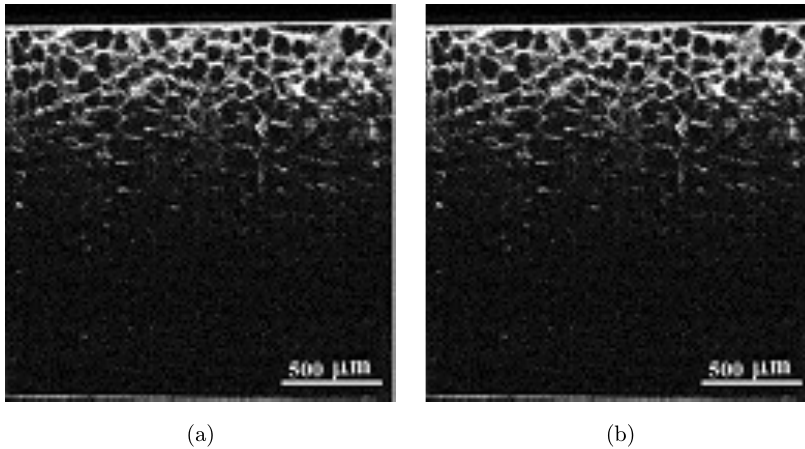
Fig. 2. OCT images of the BG-stained fat tissue before irradiation (a) and during 15 min after irradiation (b). The light source was dental diode irradiator Ultra Lume Led 5 (442 and 597 nm). The concentration of BG in ethanol (cid:1) water solution (2:3) was 6